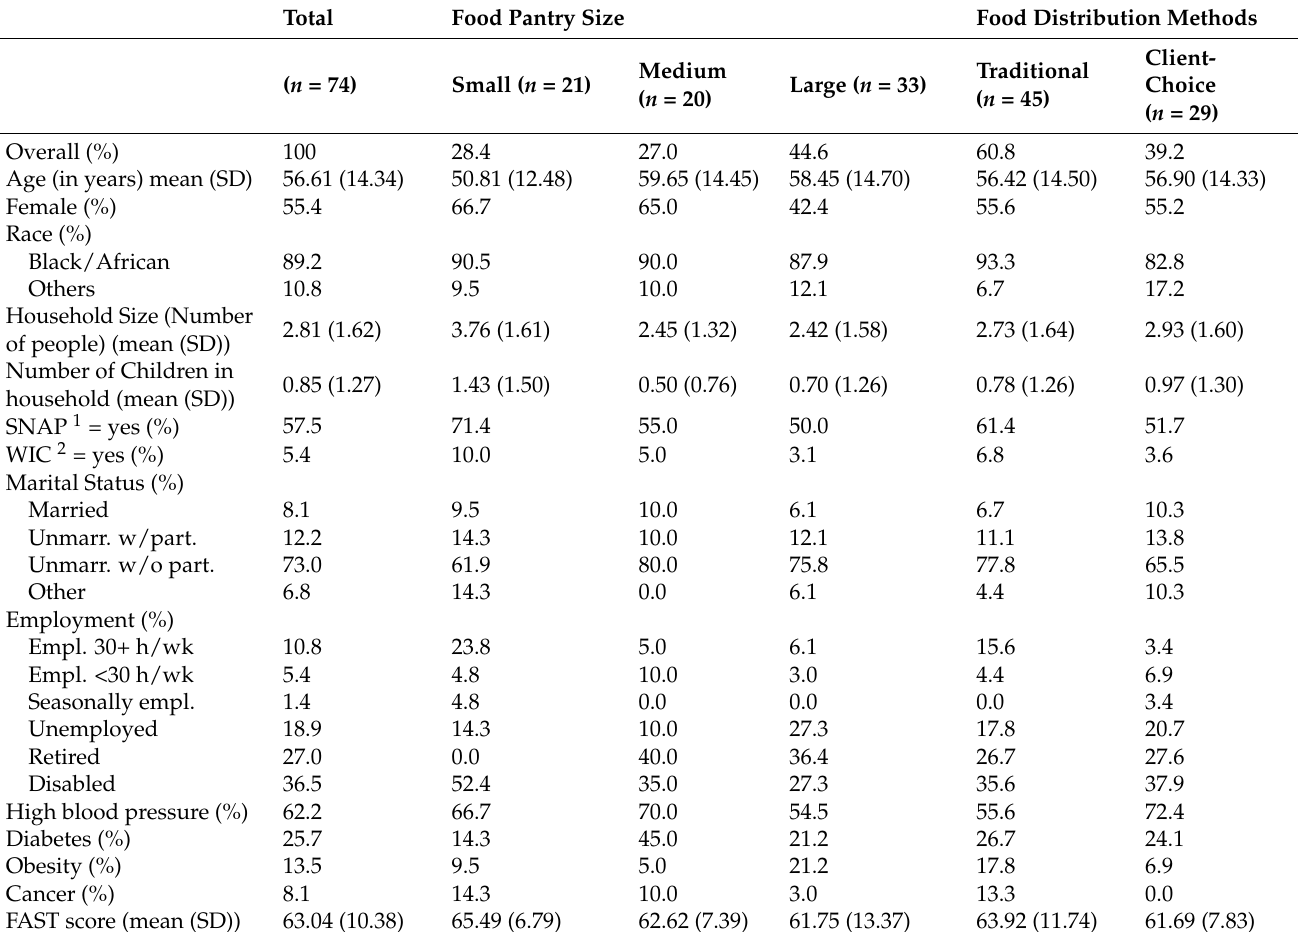
Table 1. Sociodemographic characteristics and FAST scores of clients ( n = 74) by food pantry size and distribution